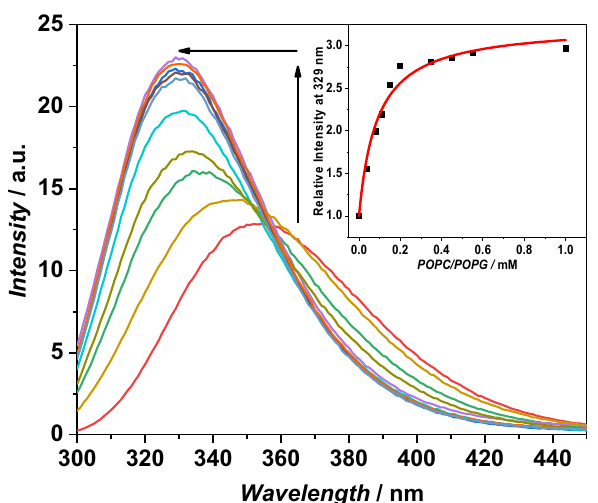
Figure 1. Fluorescence emission spectra of g-LL-III at increasing lipid concentration. The arrows indicate the increase of fluorescence and the blue shift of the position of the maximum. Inset: binding isotherm obtained by plotting the relative fluorescence intensity at 329 nm vs. lipid concentration. The red line is the best fit of experimental data (please, refer to the Materials and Methods section for details). The experiments were performed using LUVs, 10 mM sodium phosphate buffer, pH 7.4, 25